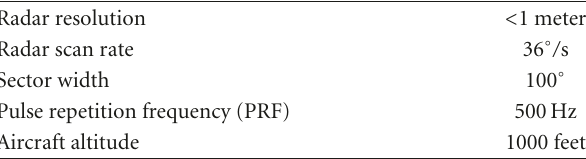
Figure 1: Speedboat used as target in trials. Table 1: Radar and aircraft operating parameters.